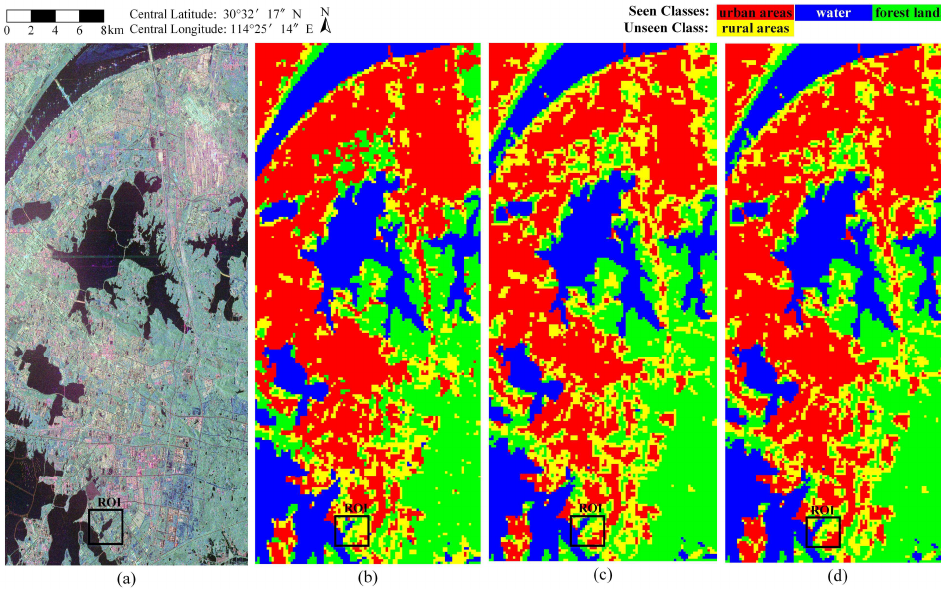
Figure 6. The Wuhan Data1 and the GZSL classification results. ( a ) The Pauli RGB image of the Wuhan Data1; ( b ) the results with the Word2Vec attributes applied; ( c ) the results with the SUN attributes applied; and ( d ) the results with the selected SUN attributes applied.